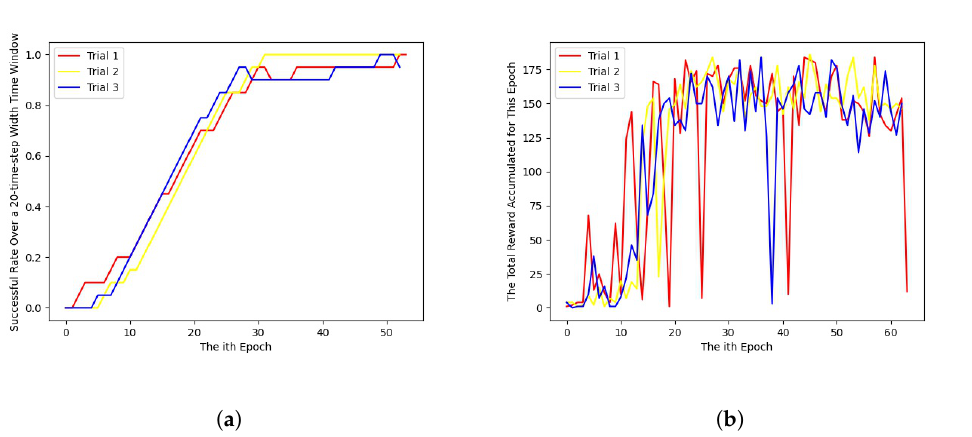
Figure 6. The training results of the SNN using R-STDP and Reward Function 3: ( a ) the success rate of the SNN controller changes over the training epochs using R-STDP learning; ( b ) the total reward accumulated in one epoch versus the number of training